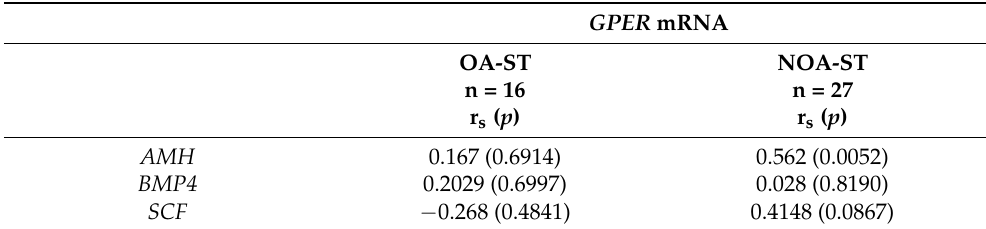
expression level in OA-ST and NOA-ST